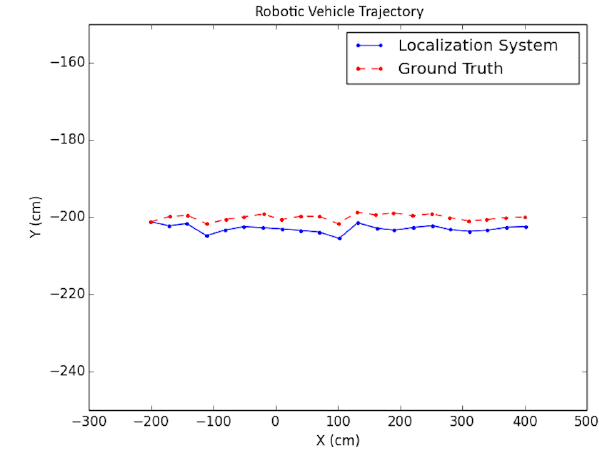
Figure 19. Simulation test trajectory 1.